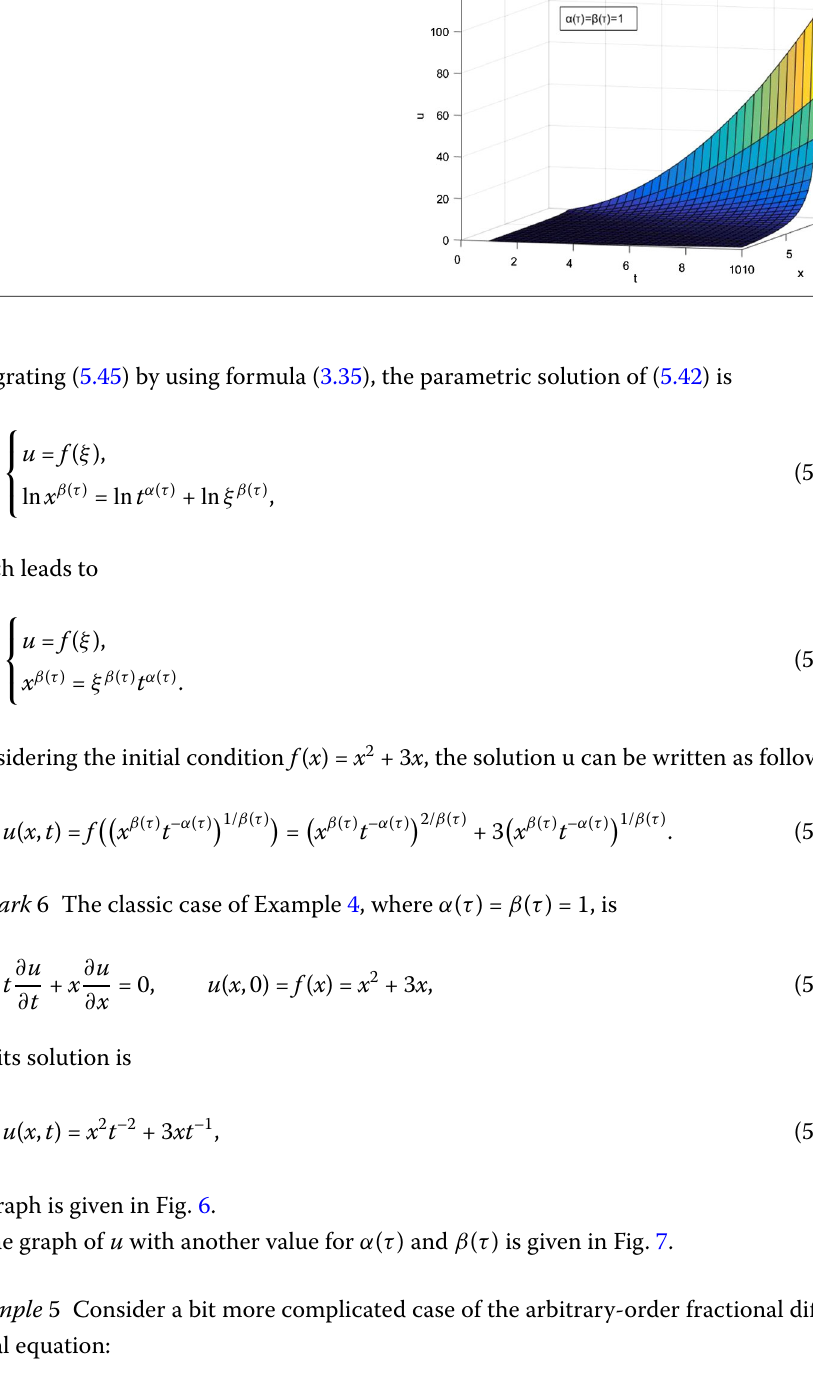
Figure 6 The graph of the solution u in Example 4, where α = β =